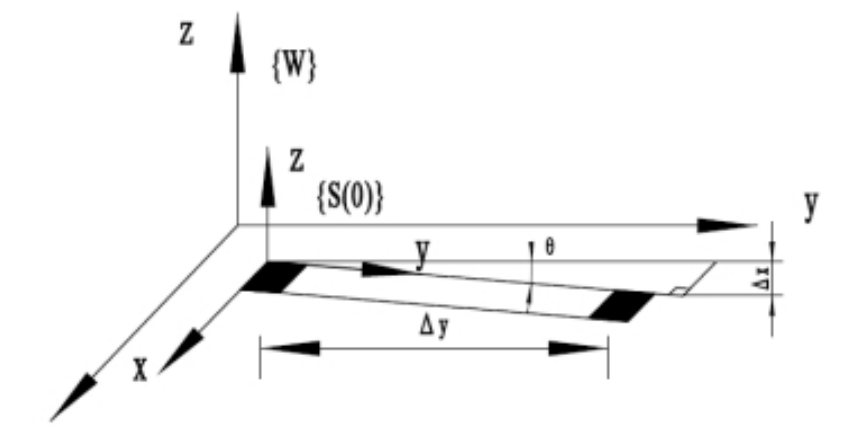
Figure 5. Calibration of coordinate system.